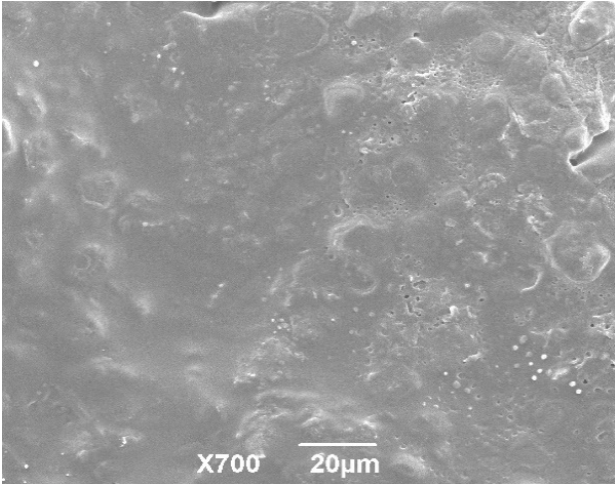
Figure 4. The SEM imaging of the coating membrane of enteric granules. The coating surface showed the relative smooth morphology.